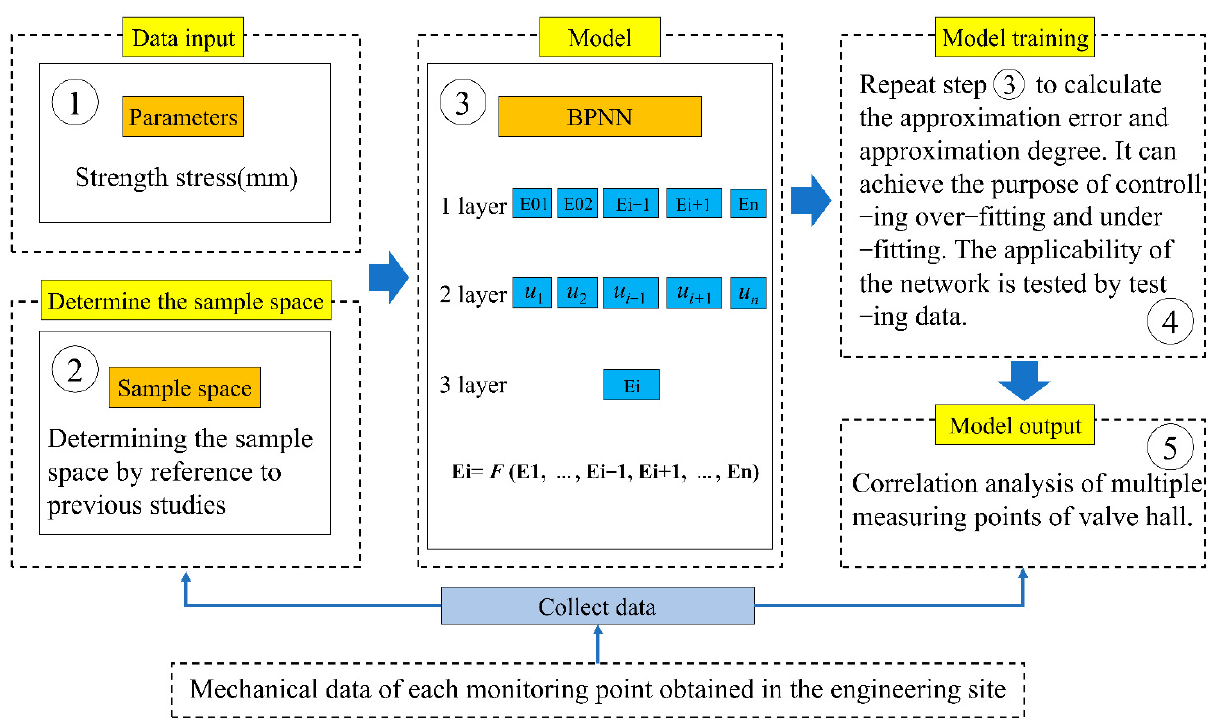
Figure 1. Research flow of intelligent analysis on mechanical properties of multiple measuring points of valve hall grid structure members based on a BPNN.